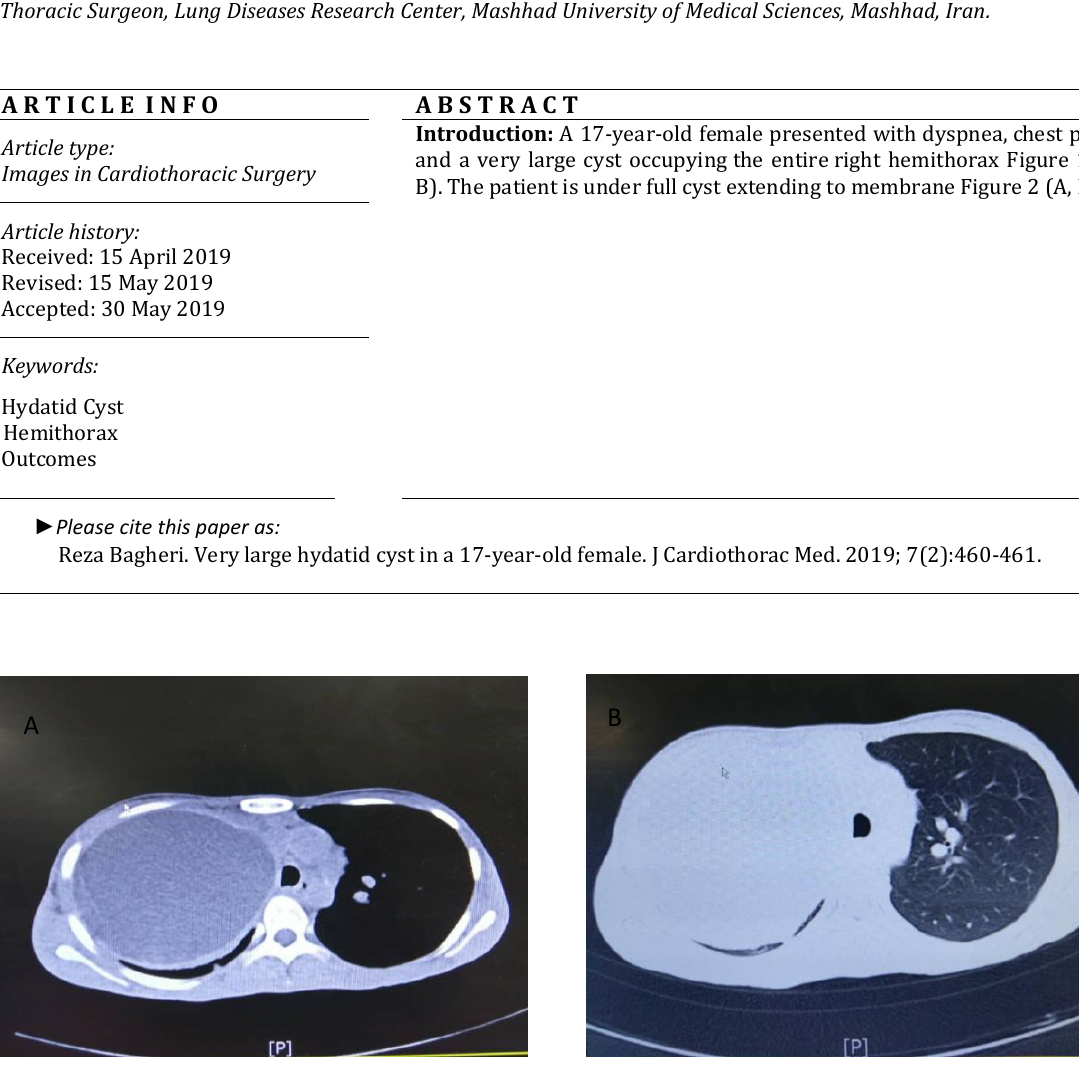
Figure 1 (A, B): Computed tomography scan and chest x-rays showing very large hydatid cyst